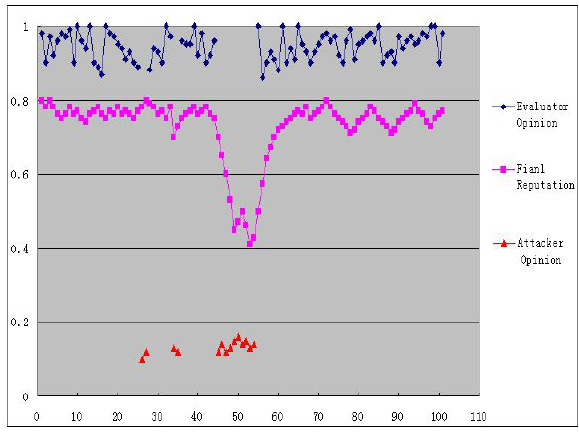
Fig. 5: Behavior of the reputation function the attacking group's members have on random personal reputations. Fig. 5 denotes the relationship of personal